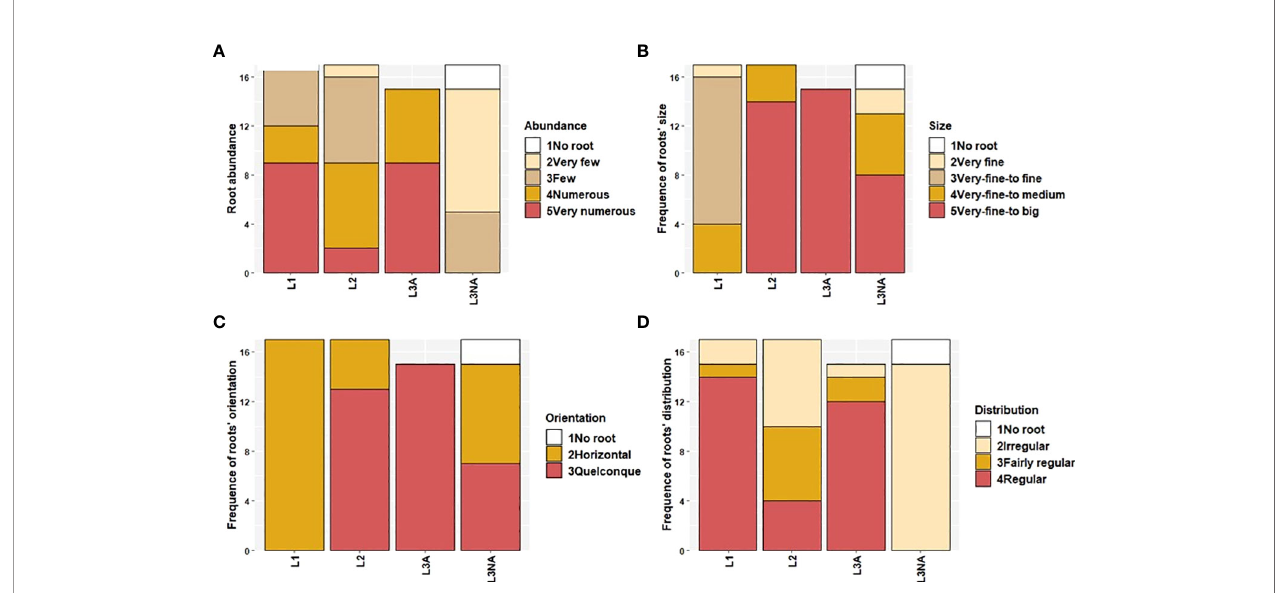
FIGURE 2 | Tree root characteristics in different layers of soil [L1: layer 1, L2: layer 2, L3A: layer 3 amended, L3NA: layer 3 unamended; (A) root abundance, (B) root size, (C) root orientation, (D) root